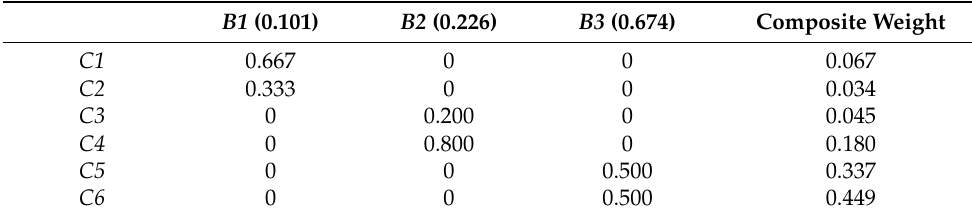
Table 4. Composite weight